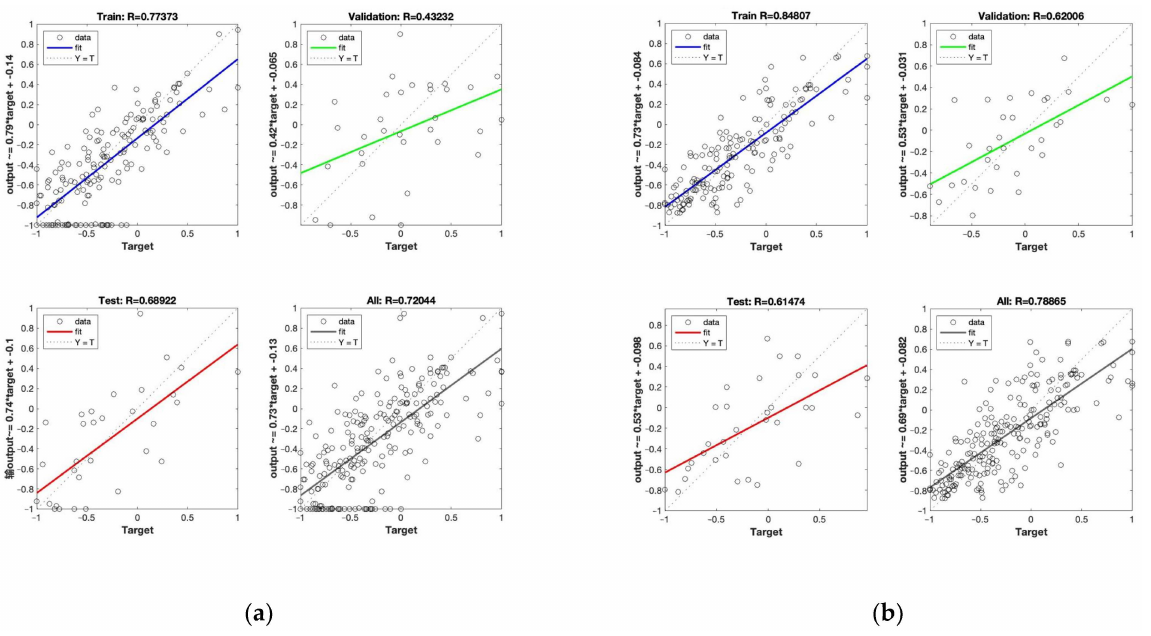
Figure 7. ( a , b ) are two graphs showing the relationship between the training set, the validation set, and the test set predicted value and the actual value when the BP and CPA-BP model predicts the surface roughness (Ra) of plywood.